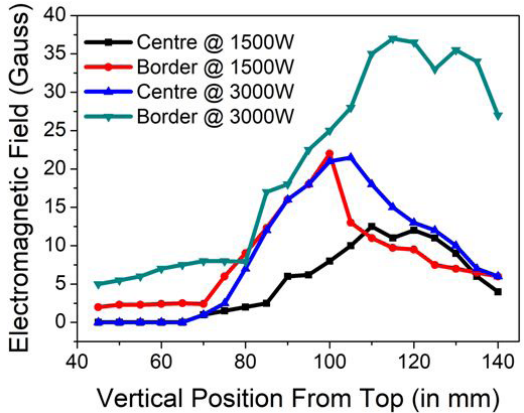
Figure 5. Electromagnetic field as a function of distance from the top of the mould measured at the centre (0 mm R) and edge (15 mm R) of the cavity for power levels of 1500 and 3000